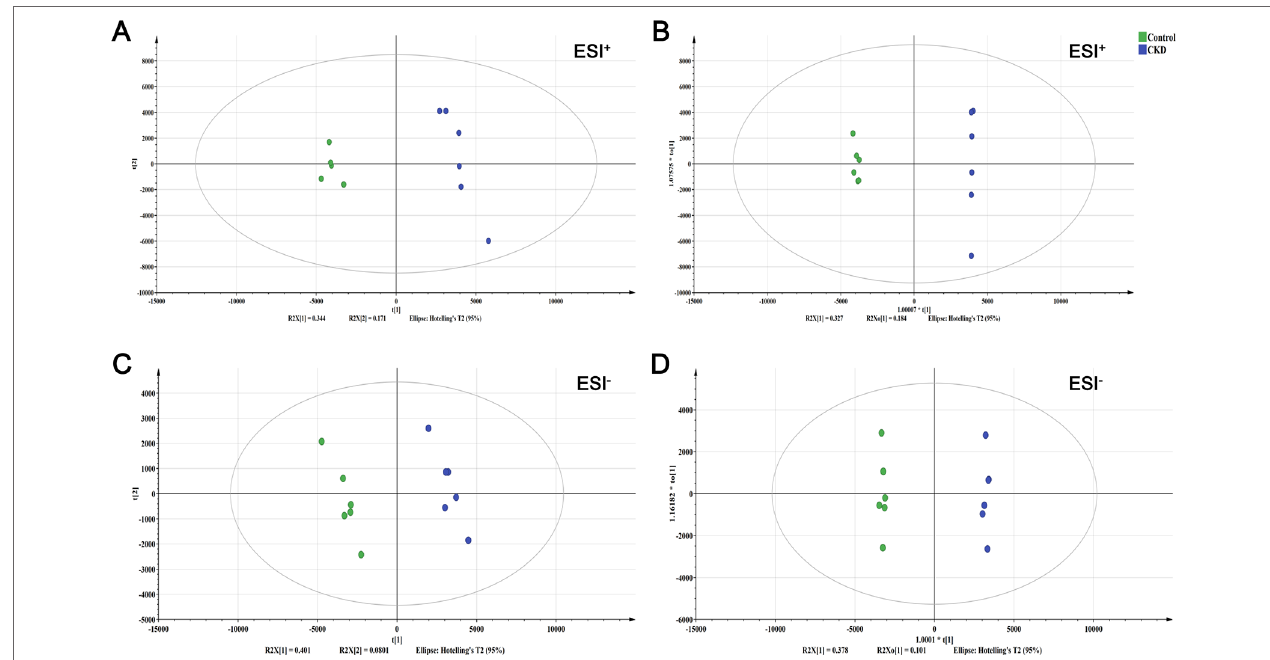
FIGURE 3 | The score plots from PCA and OPLS-DA model. (A) PCA-X score plot of positive ion mode. (B) OPLS-DA score plot of positive ion mode. (C) PCA-X score plot of negative ion mode. (D) OPLS-DA score plot of negative ion mode. ESI + means the positive electrospray ionization. ESI − means the negative electrospray ionization. Green circle corresponds to the control group; blue circle corresponds to the CKD